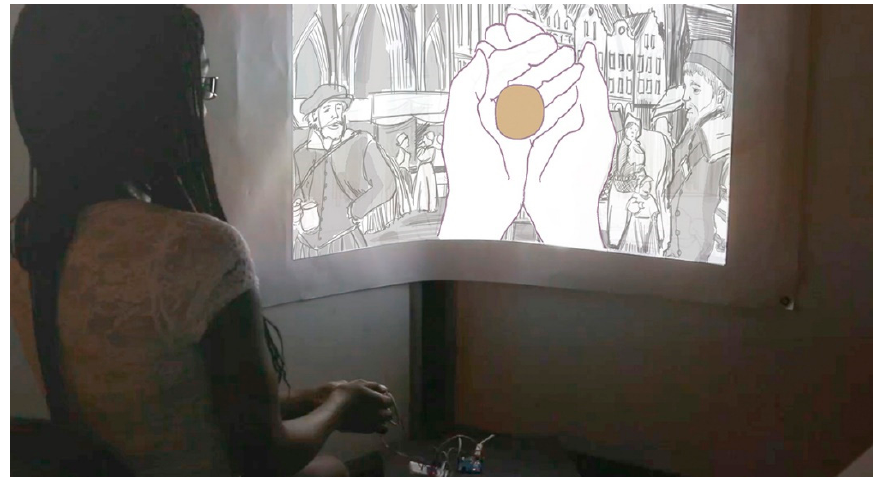
Figure 10. Experiencing Spirituality interaction.